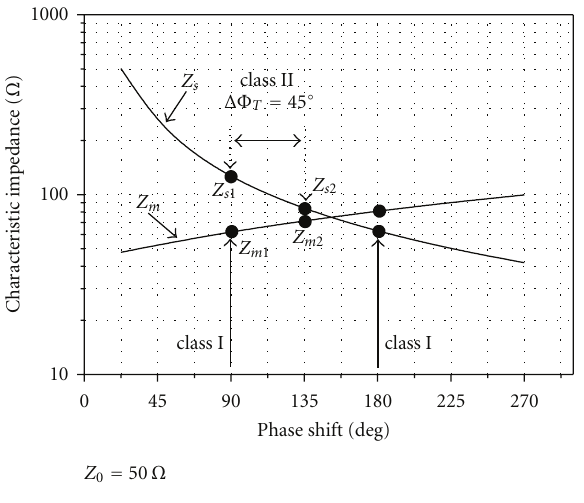
Figure 6: Design graph for 90 ◦ /180 ◦ BPS [13].